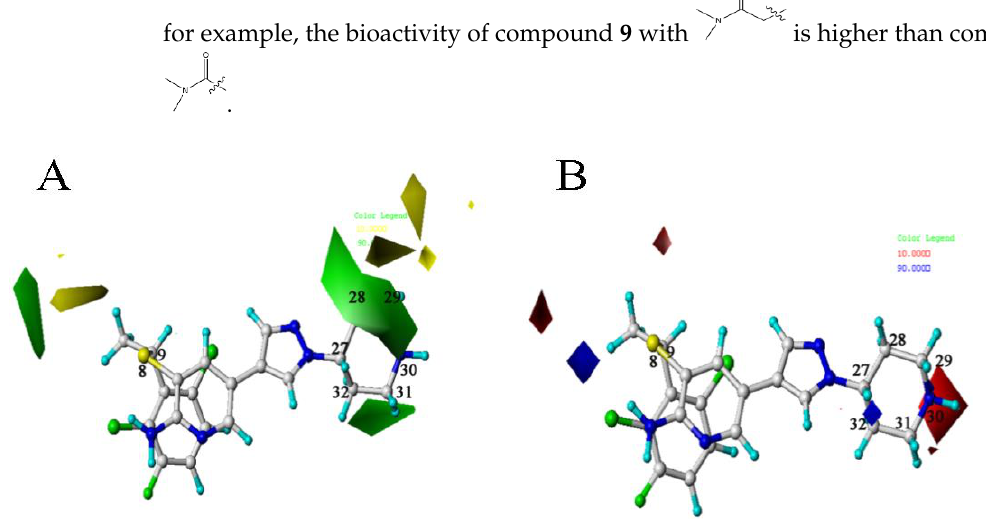
Figure 4. The CoMFA STDEV × COEFF contour maps based on template compound 4 . ( A ) The steric field. ( B ) The electrostatic field.